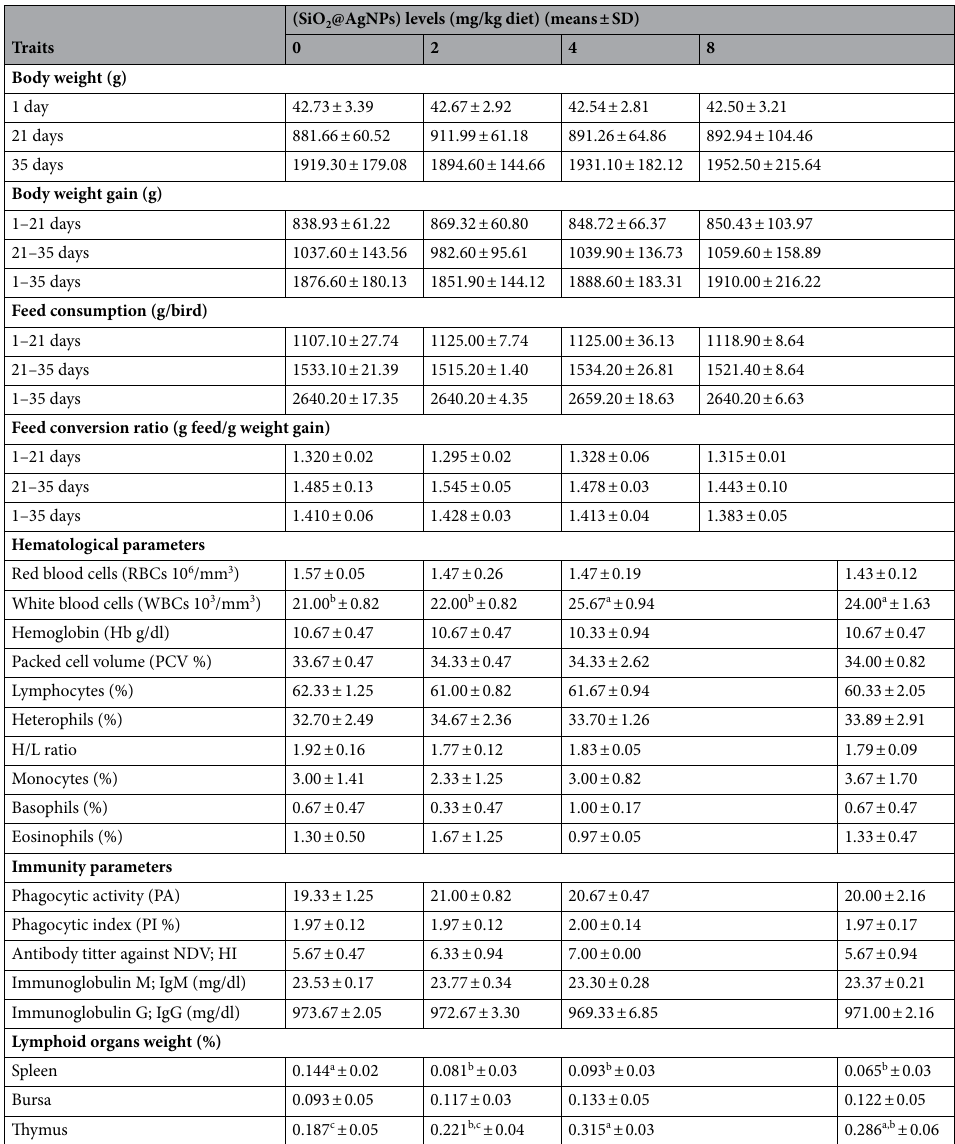
Table 2. Effect of different levels of (SiO 2 @AgNPs) on productive performance, hematological and immunological parameters of boiler chickens from 1 to 5 weeks of age (n/group = 24). Means not bearing superscripts are not statistically differed (P > 0.05). a–c Means in the same row having different letters are significantly different at (P <